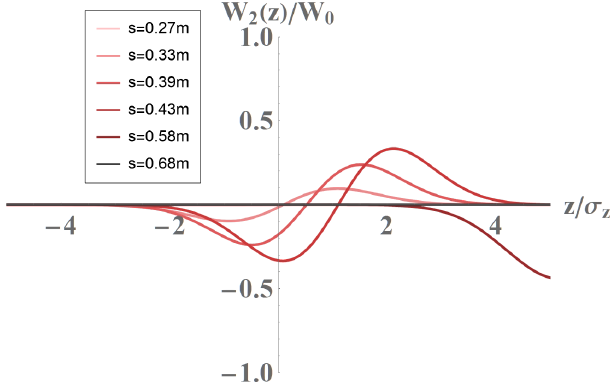
FIG. 14. Evolution of W 2 ð z Þ inside magnet B2 in beamline C by theory prediction [See Eq. (105)]. As s increases the wake “ moves ” toward positive z . For the darkest curve at s ¼ 0 . 68 m, the wake becomes insignificant for z < 5 σ z .